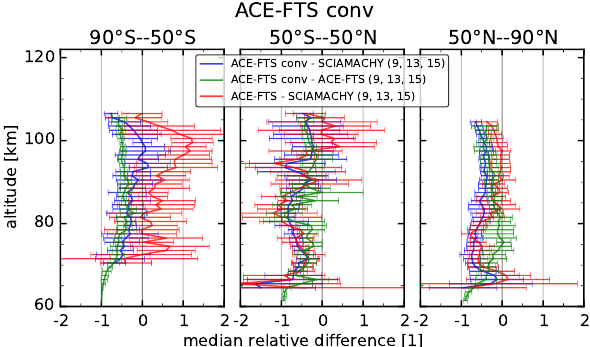
Figure 9. NO vertical difference profile of the convolved ACE-FTS Figure 10. NO vertical difference profile of the convolved SCIA- number densities n ACE-FTS conv compared to the original ACE-FTS MACHY densities n SCIAMACHY conv compared to the MIPAS V40 NO NO data (blue) and to the SCIAMACHY data (green). The difference upper-atmosphere NO densities (blue) and to the original SCIA- of the original ACE-FTS densities compared to SCIAMACHY is MACHY data (green). We also include the difference of the original shown in red. SCIAMACHY densities compared to MIPAS